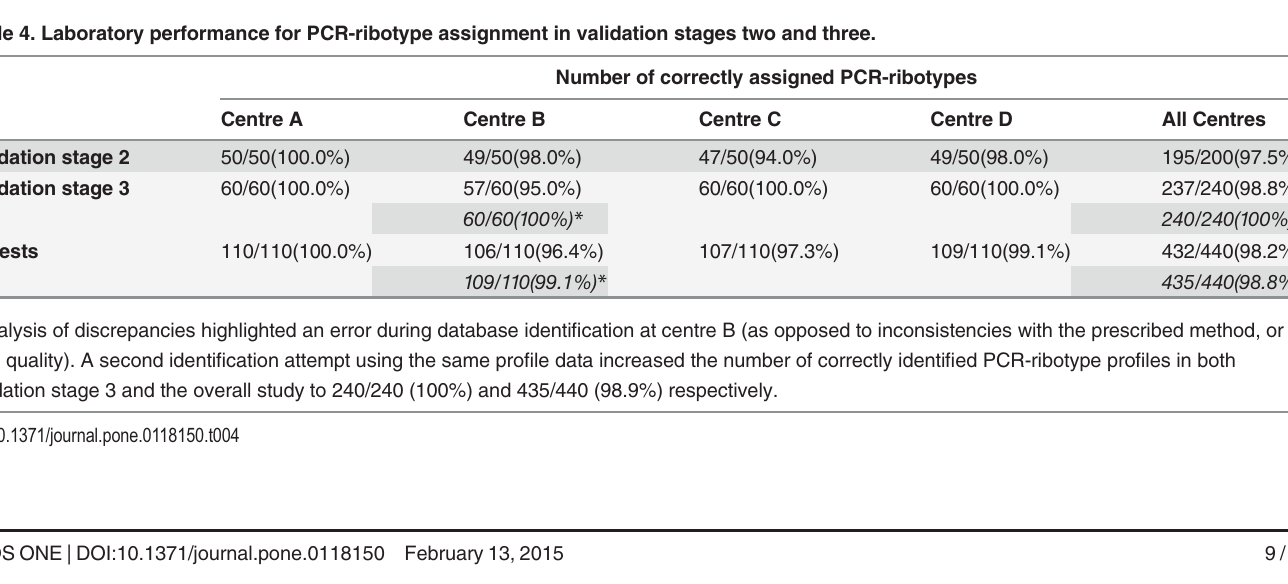
Table 4. Laboratory performance for PCR-ribotype assignment in validation stages two and three.